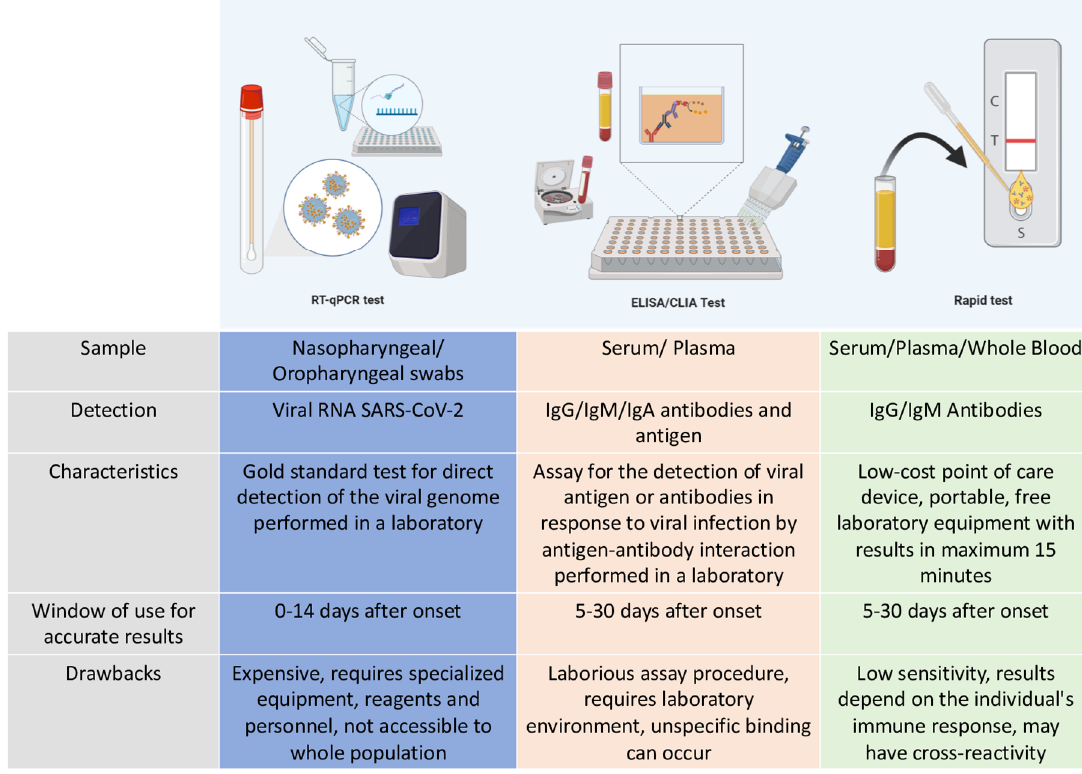
Figure 2. Differences between molecular and serological tests performed in Mexico. The characteristics of each detection method for SARS-CoV-2 infections and their different properties are compared, specifying the time window of their effectiveness to produce an accurate diagnosis. The assessment of all these characteristics allows for the correct choice of the detection method. Table 2. Serological tests validated by the National Institute for Epidemiological Diagnosis and Reference “Dr.